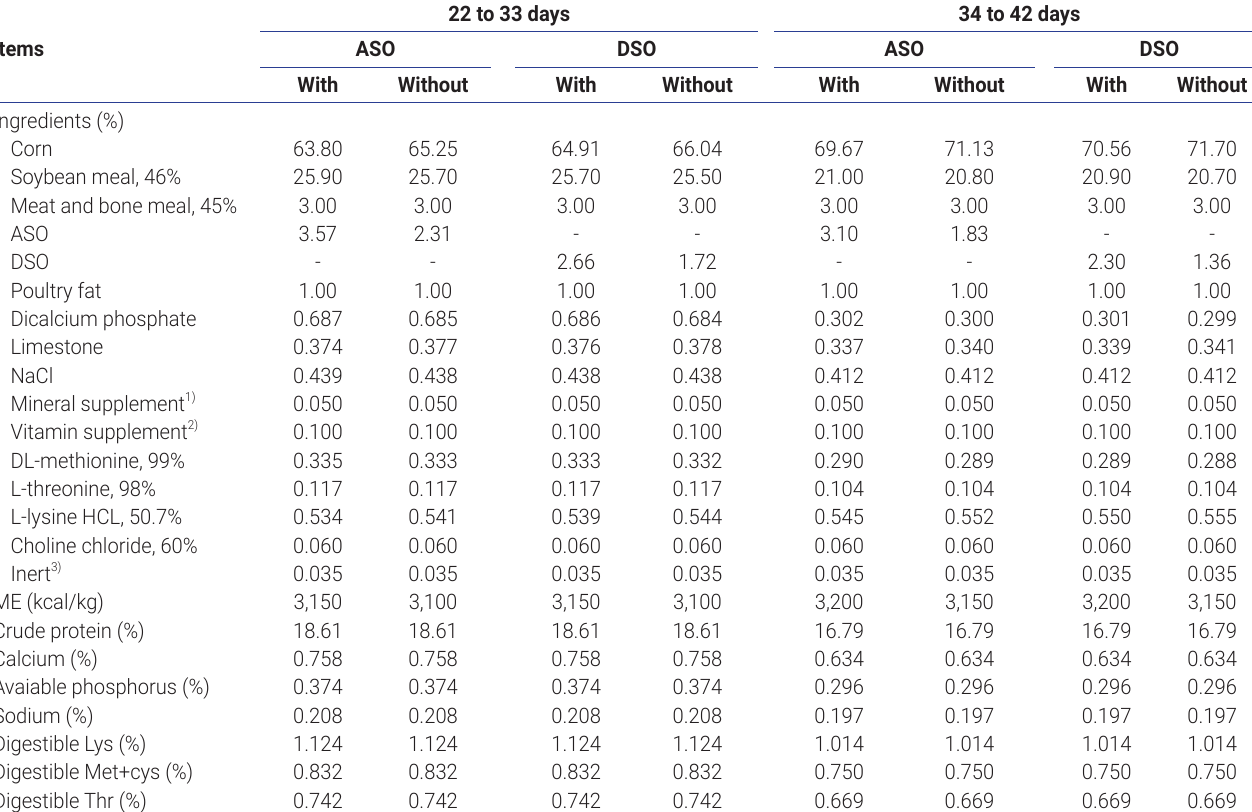
Table 2. Ingredients and chemical composition of experimental diets containing different lipid sources, with or without inclusion of emulsifier, for the grower I (22 to 33 days) and grower II (34 to 42 days) phases of broilers